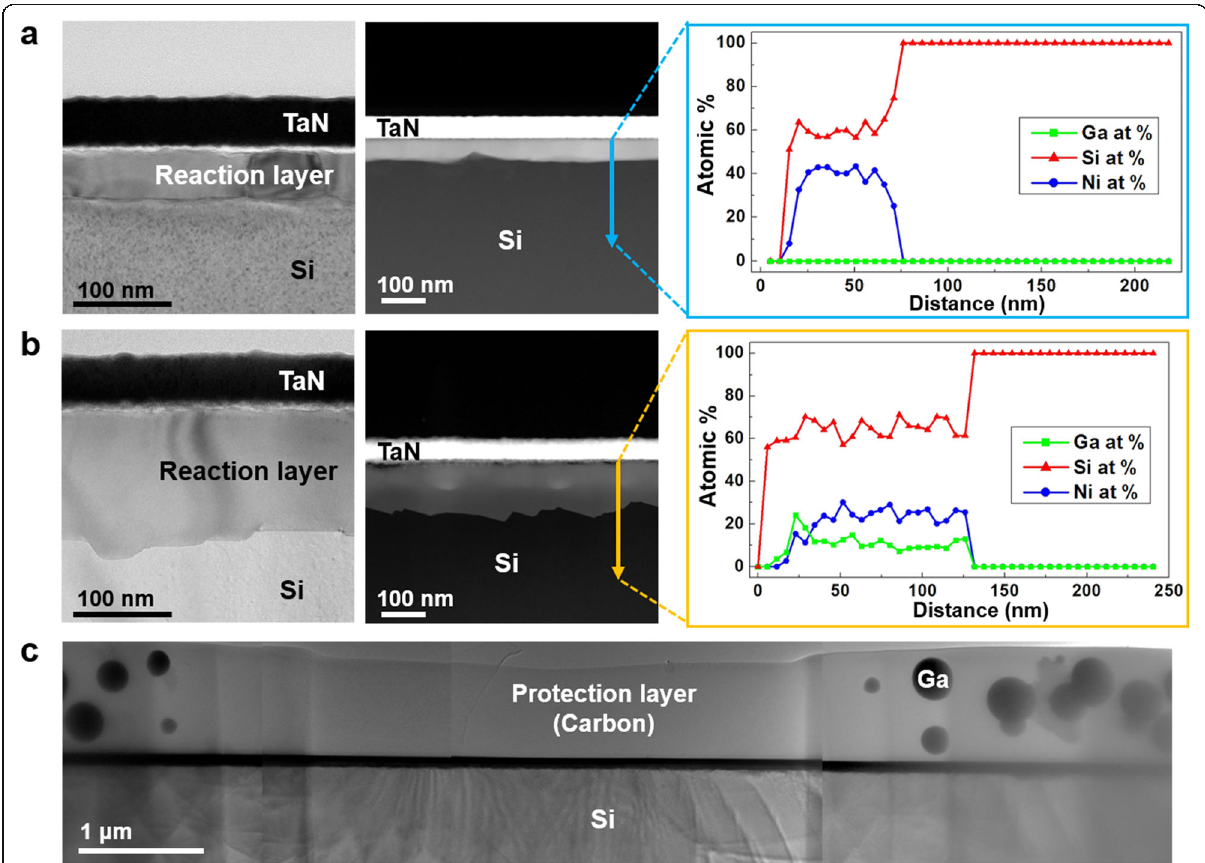
Fig. 2 The TEM/high-angle annular dark-field (HAADF)-scanning transmission electron microscopy (STEM) images and EDS line profile of the heat- treated TaN/Ni/Si thin-foil specimen prepared via ( a ) mechanical polishing and ion milling, and ( b ) FIB milling/EXLO, ( c ) The low-magnification TEM image of the TaN/Er/Si thin-foil specimen prepared via FIB